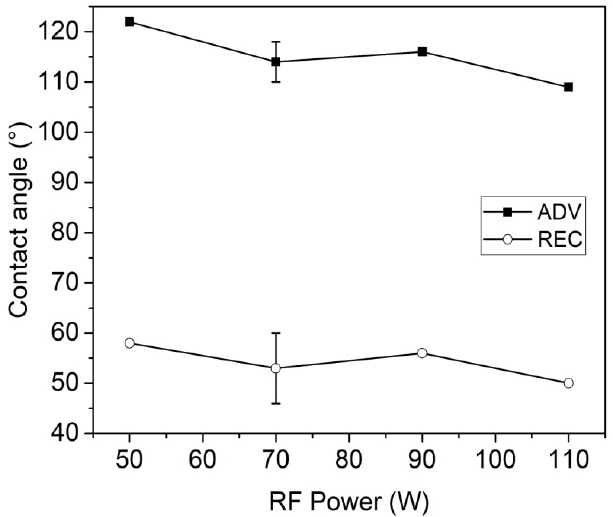
Figure 3. Advancing and receding contact angles of plasma-treated IOLs as a function of the RF peak power (SF 6 pressure = 30 Pa, DC = 50%).